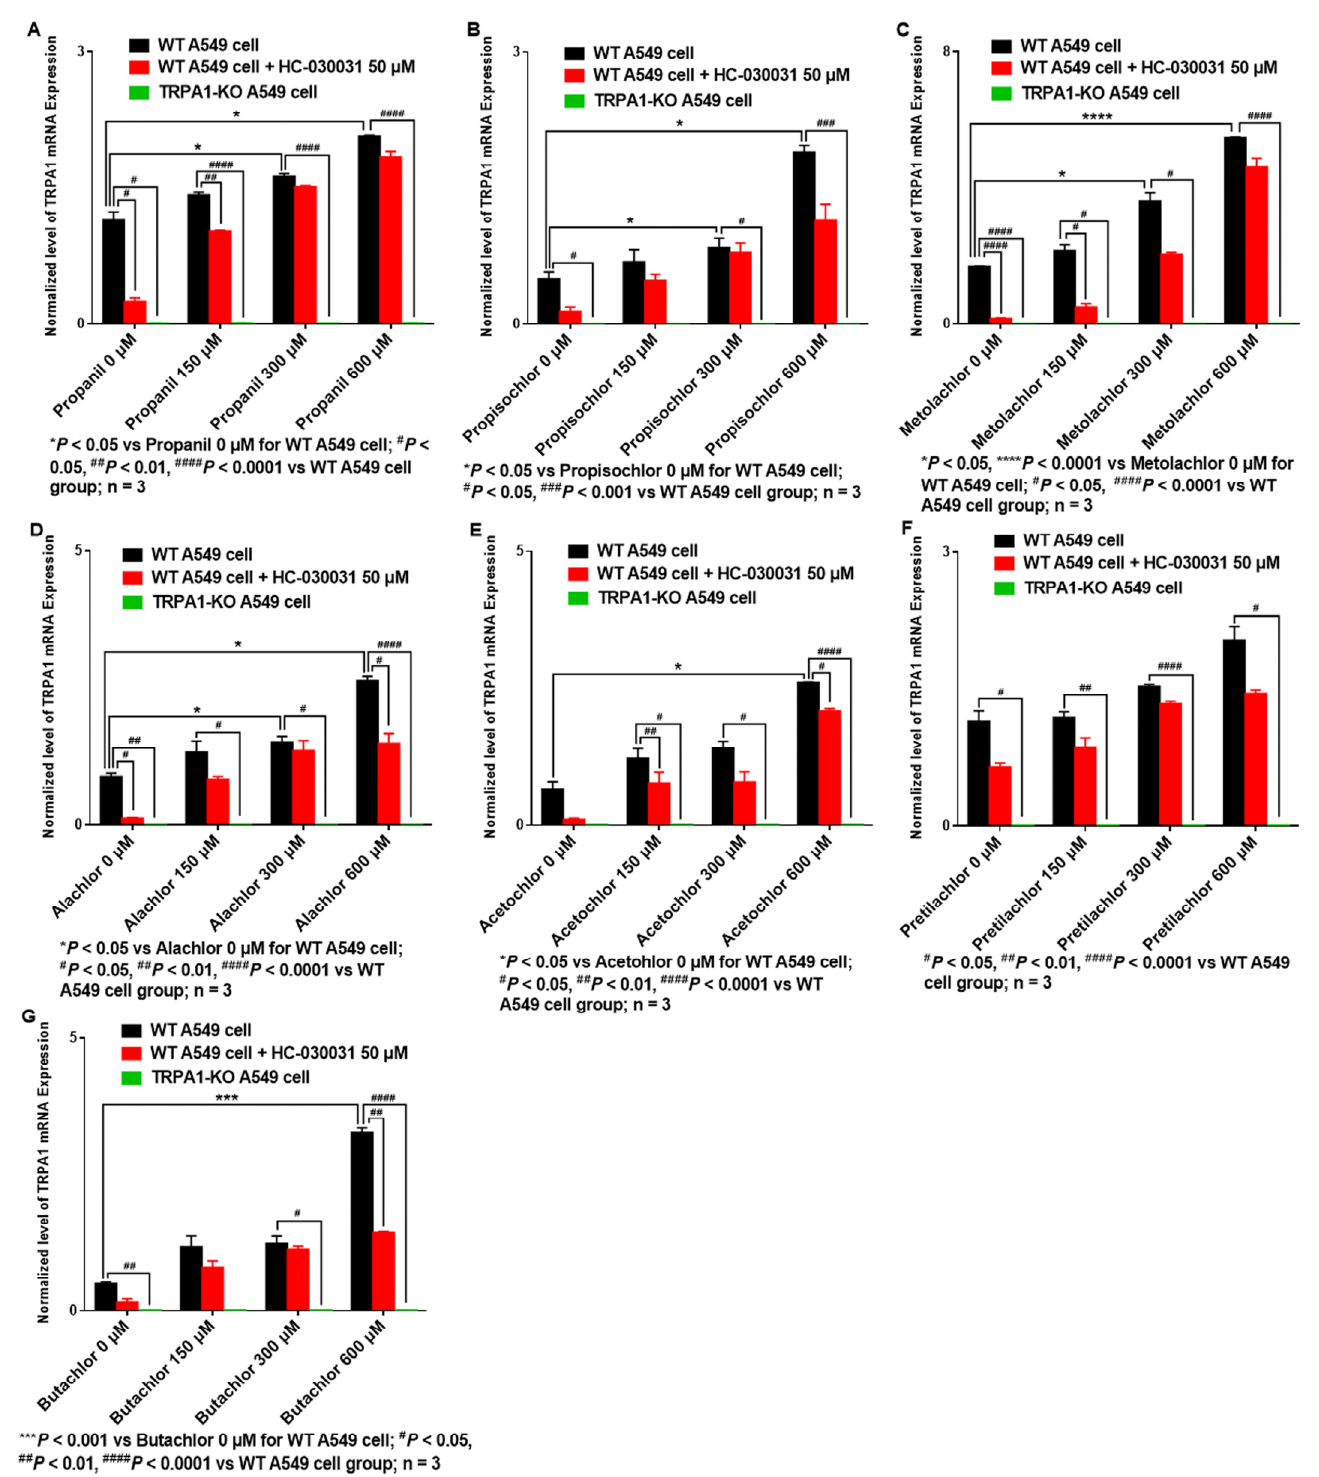
Figure 1. HC-030031 intervention or TRPA1 -KO decreases expression of TRPA1 mRNA in A549 cells treated with AHs. ( A ) Propanil, ( B ) Propisochlor, ( C ) Metolachlor, ( D ) Alachlor, ( E ) Acetochlor, ( F ) Pretilachlor, ( G ) Butachlor.